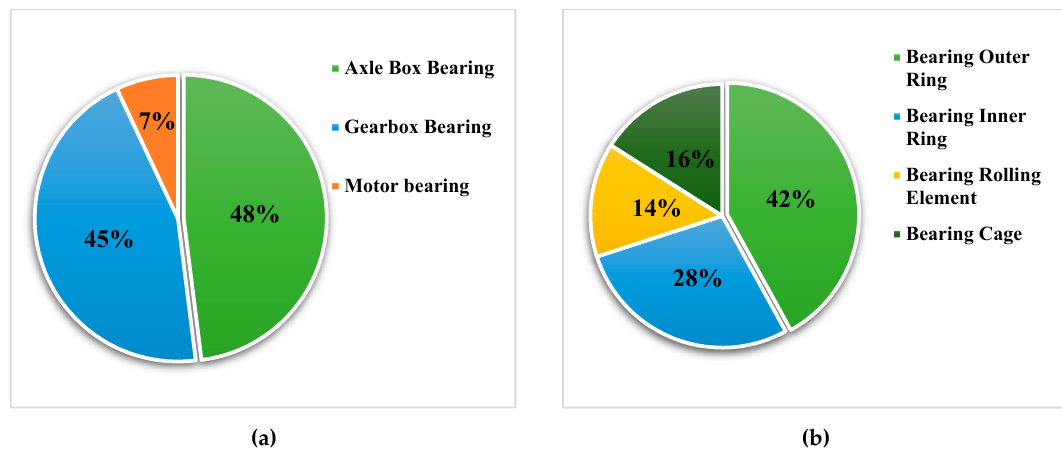
Figure 1. Statistics of bogie bearing failure. ( a ) The type of fault bearing. ( b ) The faulty part of the bearing.